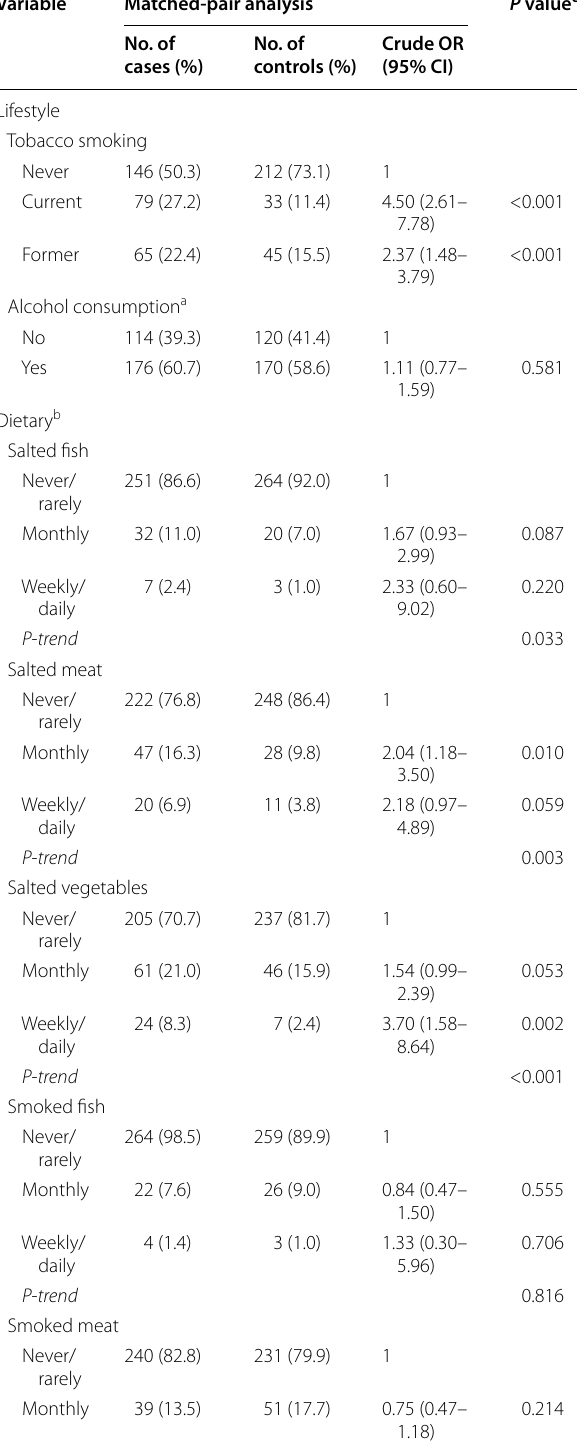
Table 2 Association between lifestyle variables, dietary habits, and weaning practices and the risk of nasopharyn- geal carcinoma Variable Matched-pair